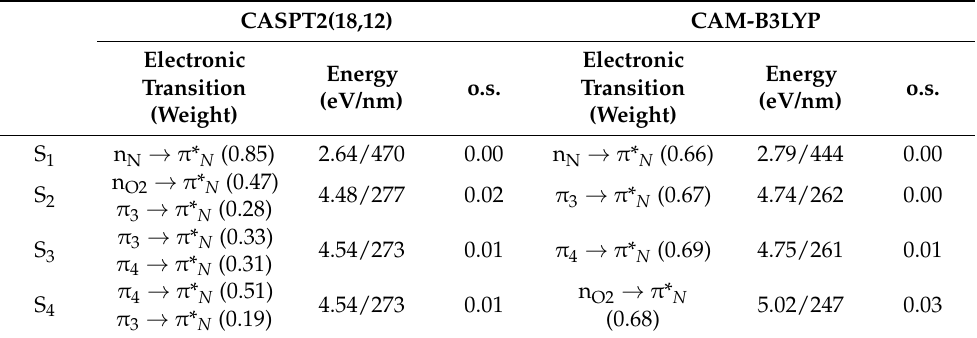
Table 2. QM/MM vertical excitation energies (in eV/nm) and oscillator strengths (o.s.), where either CASPT2(18,12)/&-31G* or CAM-B3LYP/6-31G* are used for the QM calculation. CASPT2 and TD-DFT calculations are performed on the respective MP2 and DFT GS minimum. Electronic transitions refer to orbitals shown in Figure